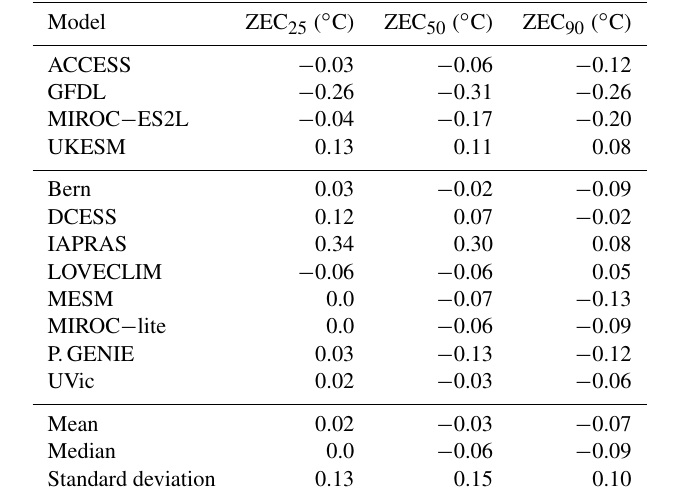
Table C1. Temperature anomaly relative to the year that emissions ceased, averaged over a 20-year time window centred on the 25th, 50th, and 90th year following the cessation of anthropogenic CO 2 emissions (ZEC 25 , ZEC 50 , and ZEC 90 , respectively) for the A2 (750PgC 1%) experiment.